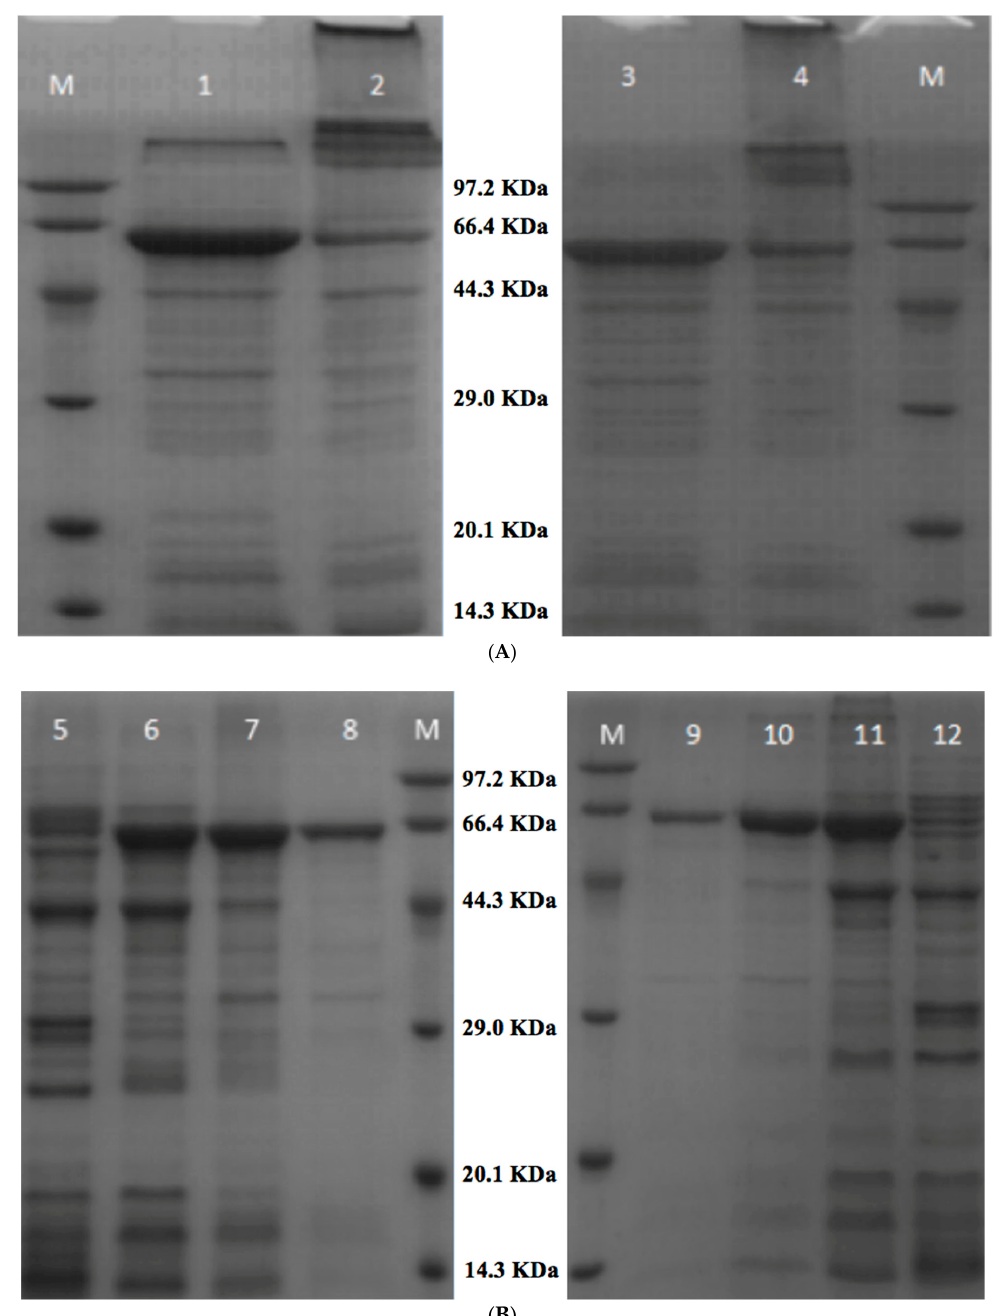
Figure 4. SDS-PAGE analysis of the prokaryotic-expressed target protein in 10% SDS polyacrylamide gel. ( A ) M: 100 kDa protein marker (Transgene); Lane 1: Msti-94 reduced protein, Lane 2: Msti-94 non-reduced protein, Lane 3: Msti-16 reduced protein, Lane 4: Msti-16 non-reduced protein; ( B ) Lane 5–8: Msti-94 expression protein elution via 50 mM, 100 mM, 200 mM, 500 mM imidazole, respectively; M: 100 kDa protein marker (Transgene); Lane 9–12: Msti-16 protein expression elution using 500 mM, 100 mM, 200 mM, and 50 mM imidazole, respectively; Isopropyl β -D-1-thiogalactopyranoside (IPTG) at the final concentration of 1 mM, induction at 37 °C for 3 h; non-reduced without IPTG; breaking the bacteria with a buffer of 20 mM PBS, 150 mM NaCl, pH 7.4.